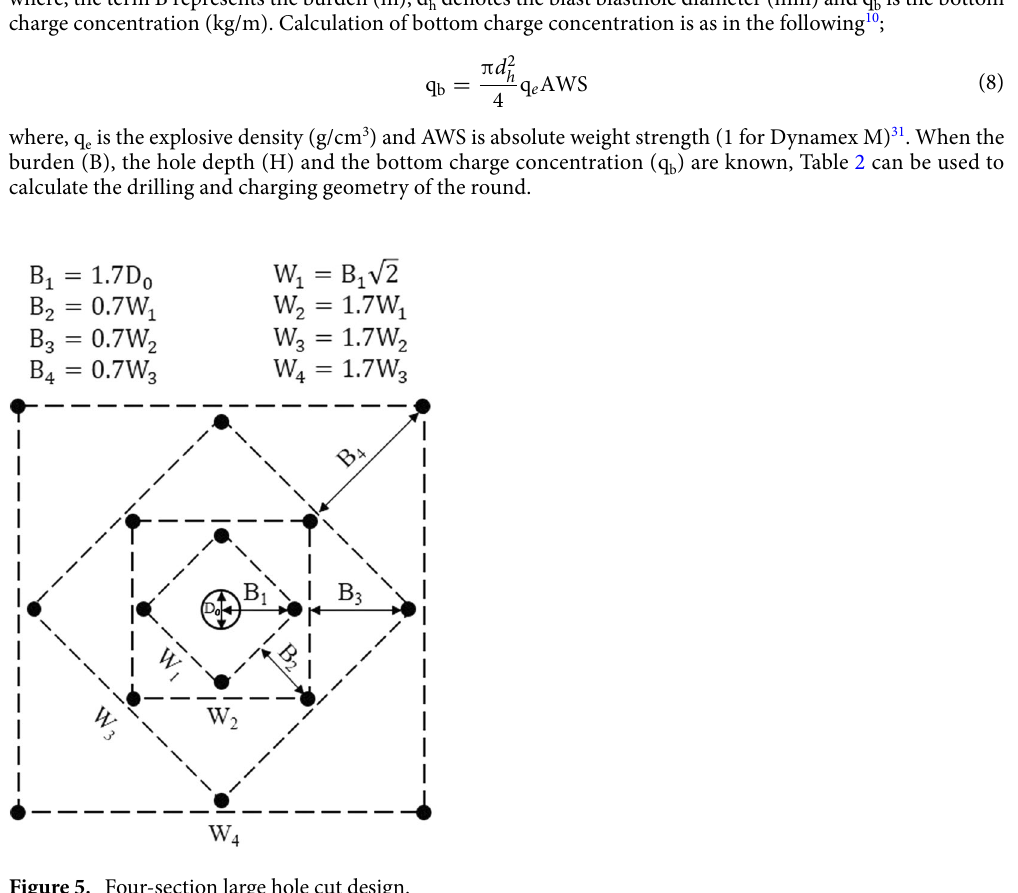
Figure 5. Four-section large hole cut